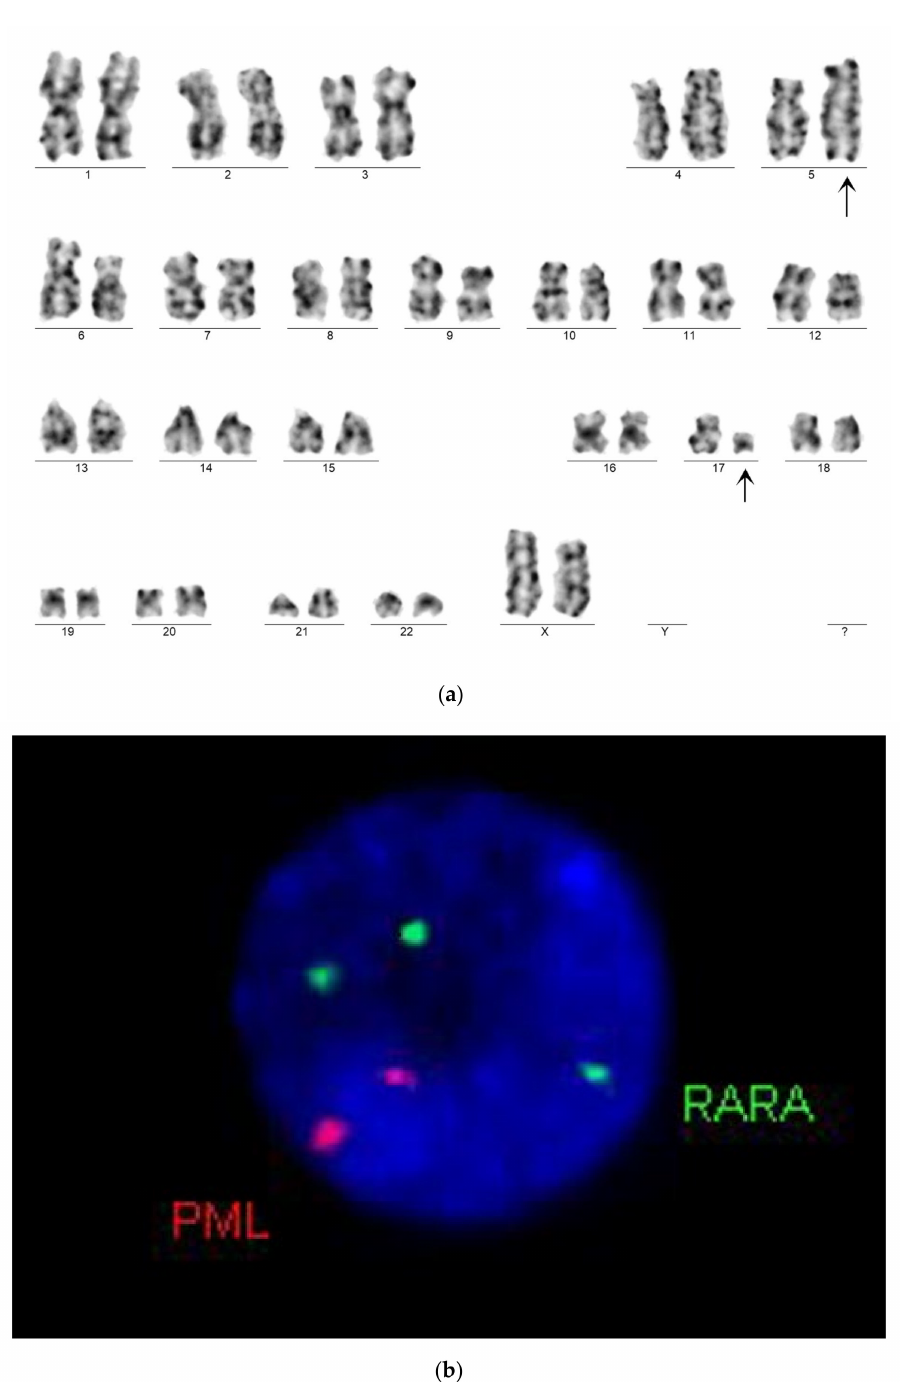
Figure 5. ( a ) Representative karyogram of t(5;17)(q35;q21) translocation. Arrows show the derivative chromosomes taking part in the translocation. ( b ) An interphase nucleus with two copies of PML signal (red) and three copies of RARA signal (green) indicating the translocation of RARA gene. Abbreviations: PML: promyelocytic leukemia protein, RARA: retinoic acid receptor